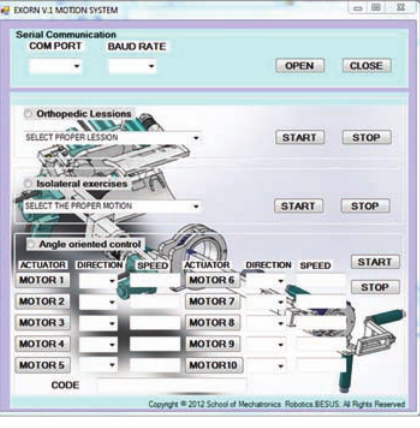
Figure 19: GUI model.